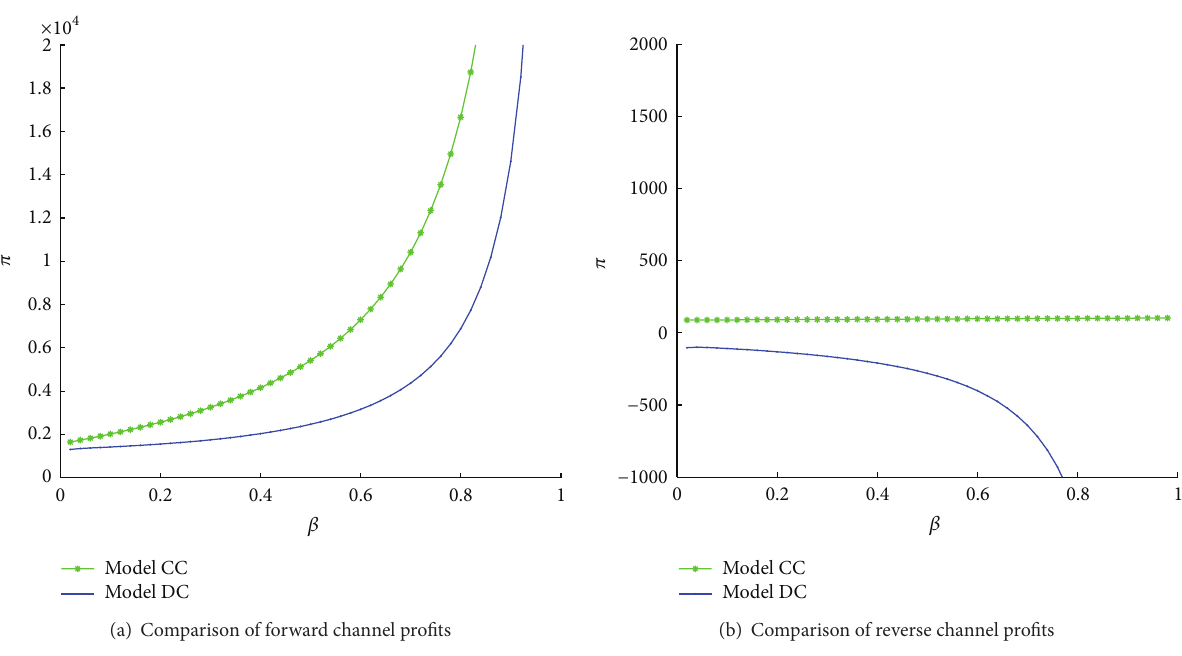
Figure 7: The profit of coordinated collection versus decentralized